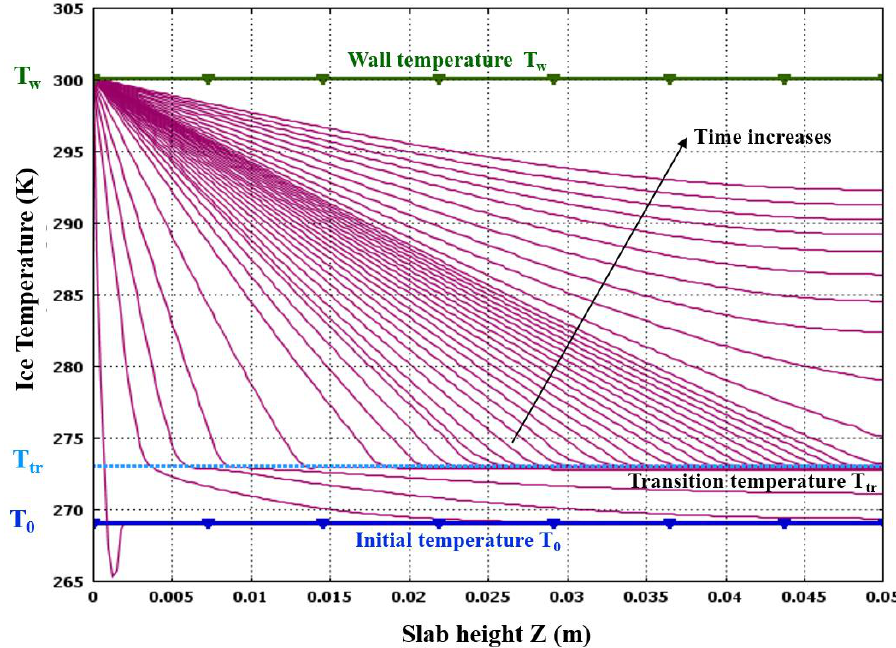
Figure 6. Evolution of ice temperature vs. time along the slab height. Figure 7 shows the 2-D temperature profile after one (a), three (b), six (c), and nine (d) hours of heating; respectively. The figure gives an example of simulation results and output of postprocessing capabilities in COMSOL. It shows how the melting front moves in space and time in the axial direction along the slab height, as the side and top bounda- ries are assumed to be adiabatic and, hence; the thermophysical properties are homoge- neous in the radial direction. It also shows the increase in temperature within the molten layers and the continuous update of the temperature field with the displacement in the solid front that is changing cautiously with time. ( a )